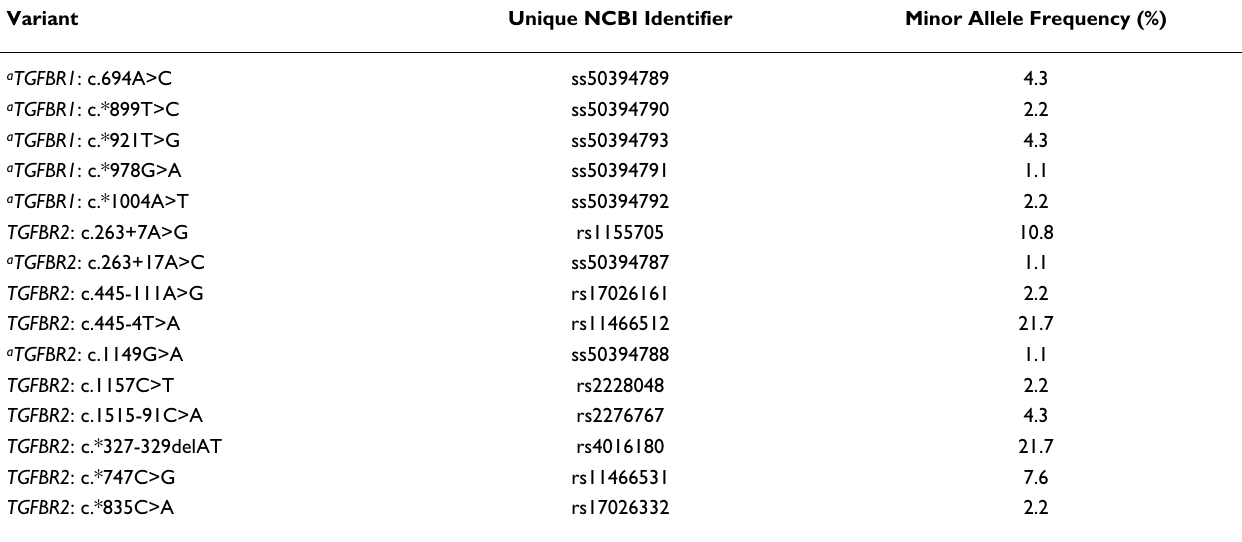
Table 6: Minor allele frequencies of identified variants in TGFBR1 and TGFBR2 genes, based on genotyping of 48 healthy control individuals. Accepted GenBank accession numbers for the reference sequences describing TGFBR1 and TGFBR2 gene variants are DQ383416 – DQ383424 and DQ377553 – DQ37759 respectively.